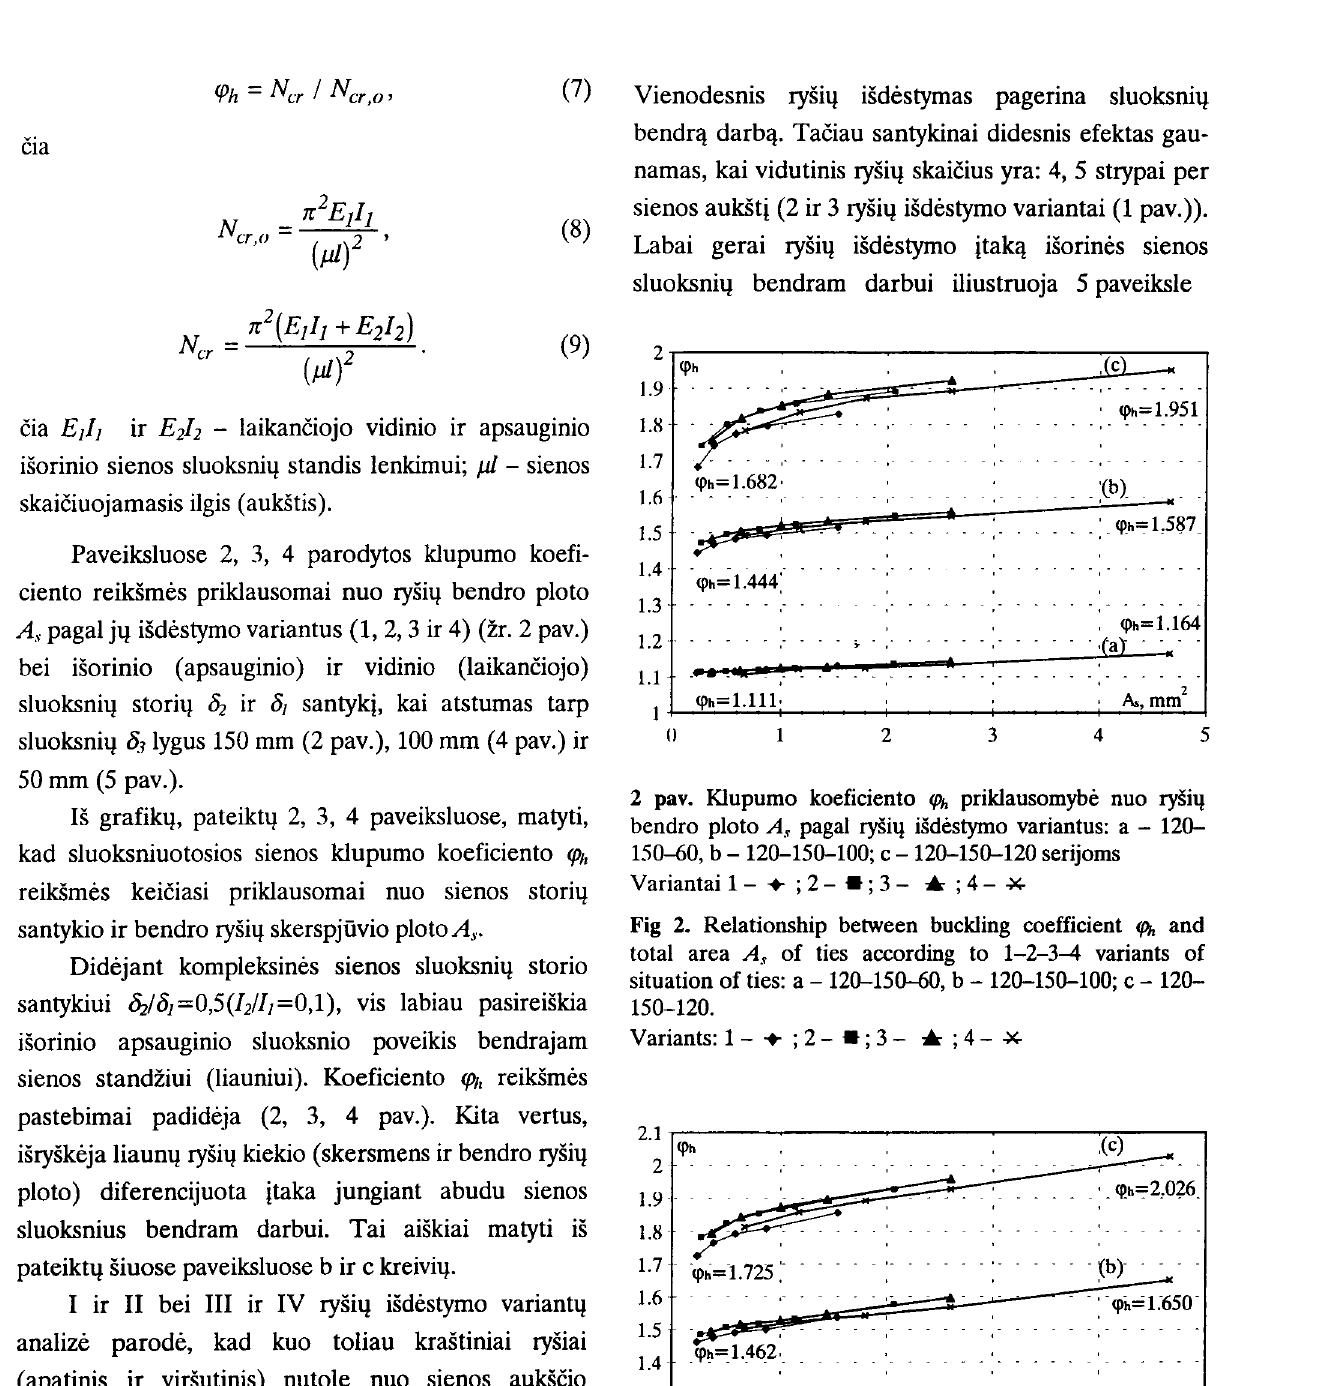
3 pav. Klupumo koeficiento rp, priklausomybe nuo ry8iq bendro ploto A, pagal ry8iq isdestymo variantus: a - 120- * ; 4- .x. Variantai 1- + ; 2- •; 3- Fig 3. Relationship between buckling coefficient rp, and total area A., of ties according to 1-2-3-4 variants